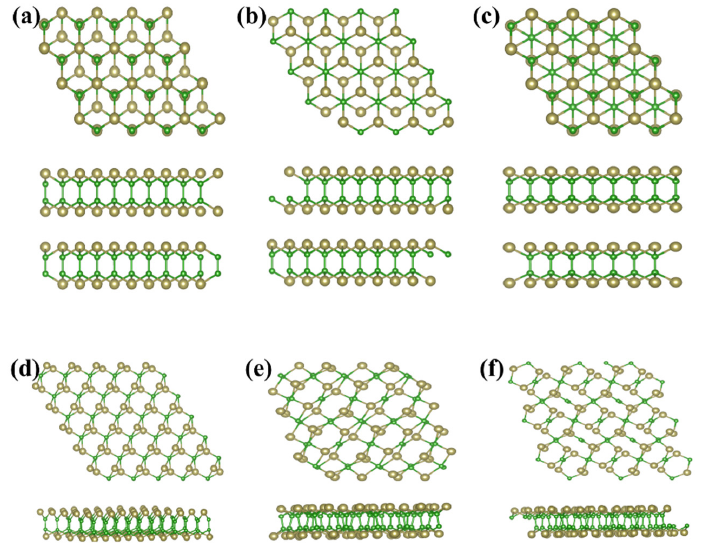
Figure 5. Six structures constructed by stacking( a–c ) and jointing( d–f ) α -TeB and β -TeB.